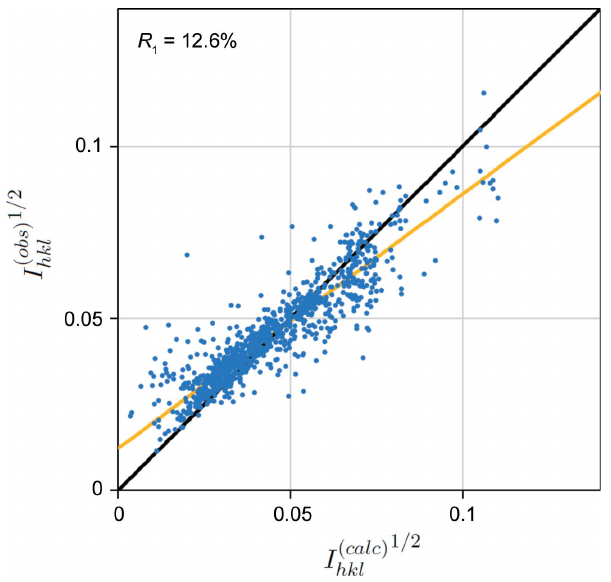
Figure 7 R 1 calculation for cRED silicon data with a Bloch-wave model, using the nominal direct beam path (red line in Fig. 3) and a specimen thickness of 190 nm. The kinematically forbidden reflections identified in Fig. 4 now have non-zero values. The black line marks perfect correspondence ( R 1 = 0) and the orange line a least-squares linear fit. R 1 =